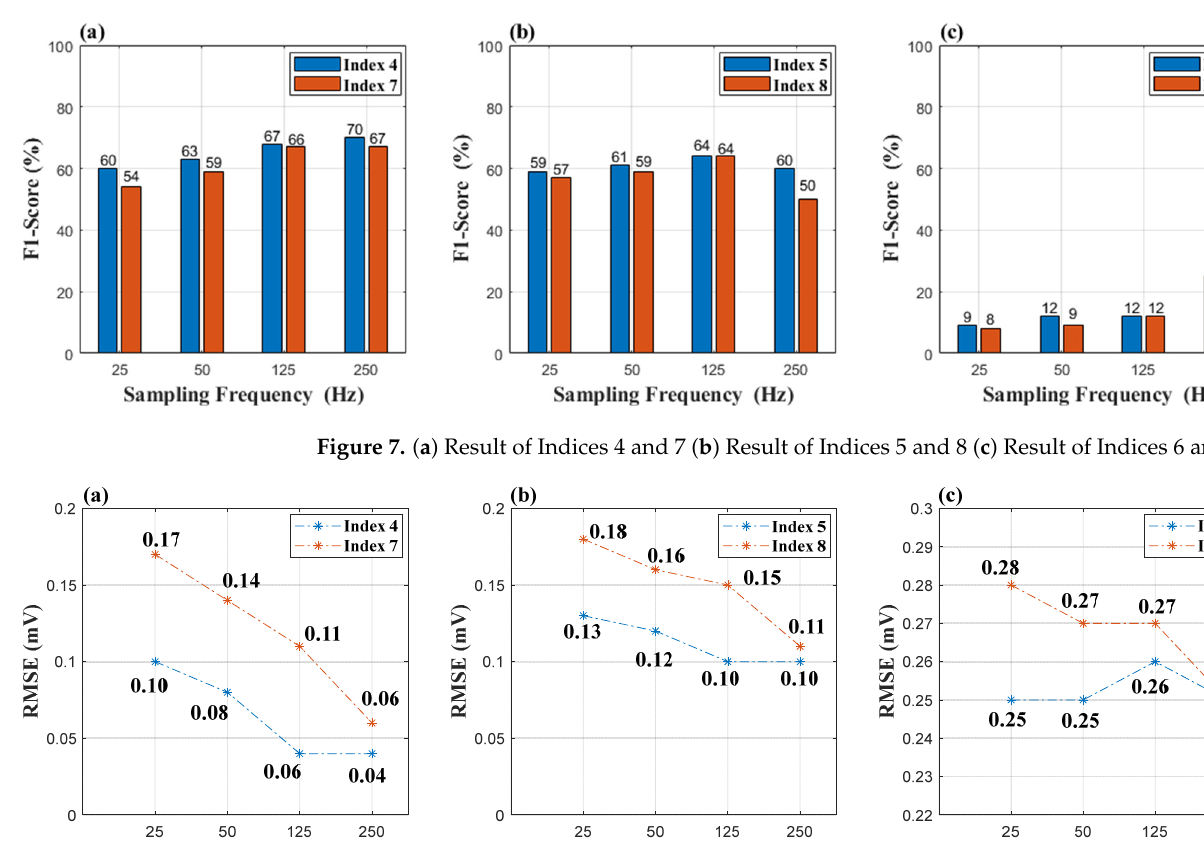
Table 3. Experimental results of Index 10 and Index 1.